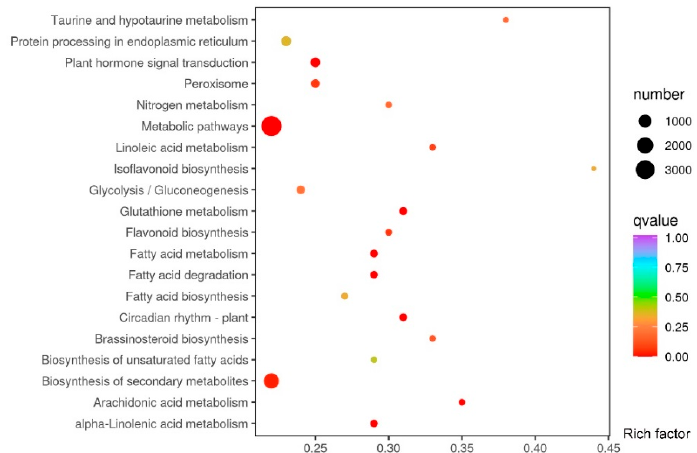
Figure 5. Statistics of KEGG pathway enrichment of DEGs. Rich factor represents the ratio of the number of DEGs enriched into the pathway to the total number of genes annotated into the pathway.